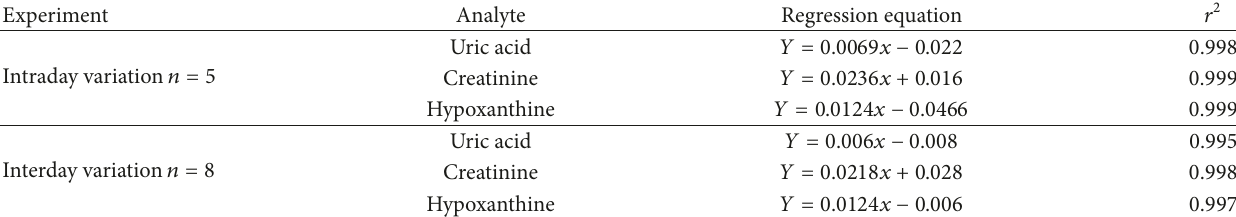
Table 1: Regression equation obtained for interday and intraday variation of uric acid, creatinine, and hypoxanthine.